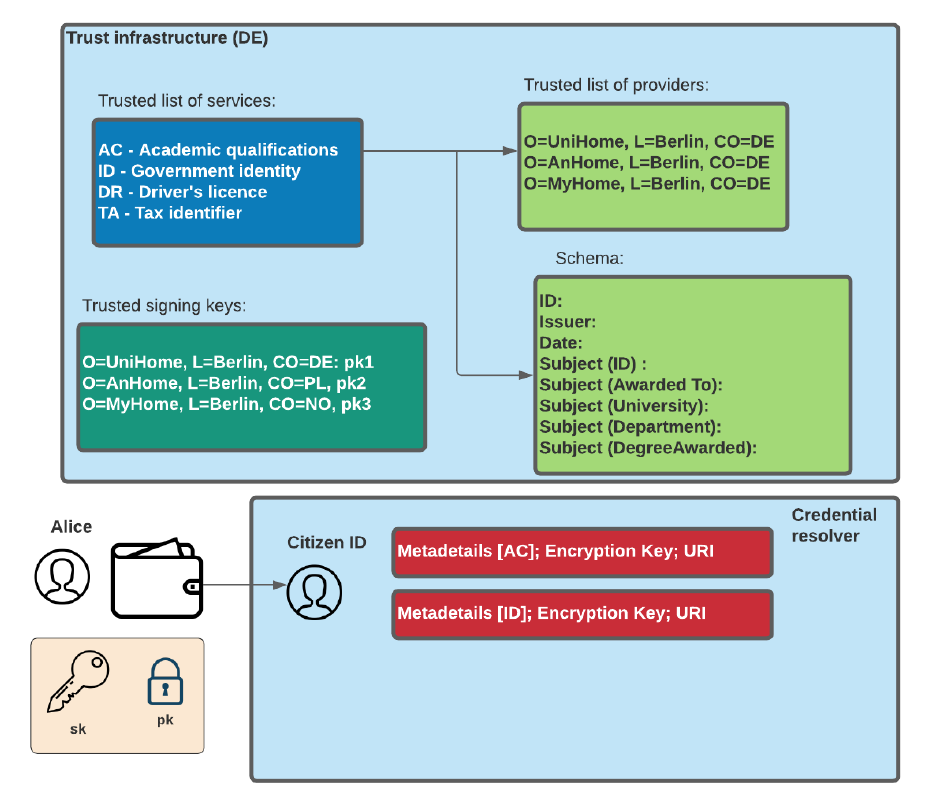
Figure 6. Trust infrastructure within